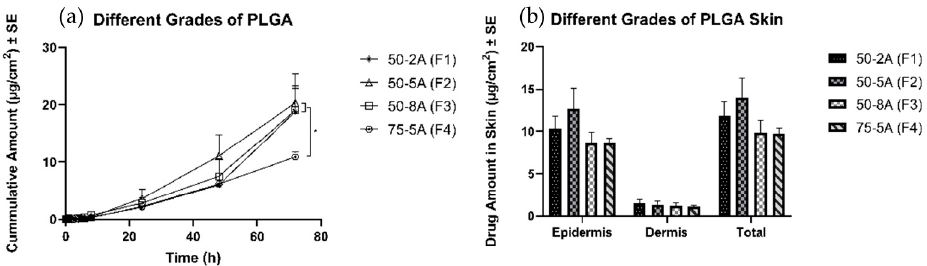
Figure 4. Permeation profiles of TS through porcine ear skin for the di ff erent types of PLGA. The group is representative of di ff erent types of PLGA: ( a ) Cumulative amount ( b ) Average amount in the epidermis, dermis, and total skin.